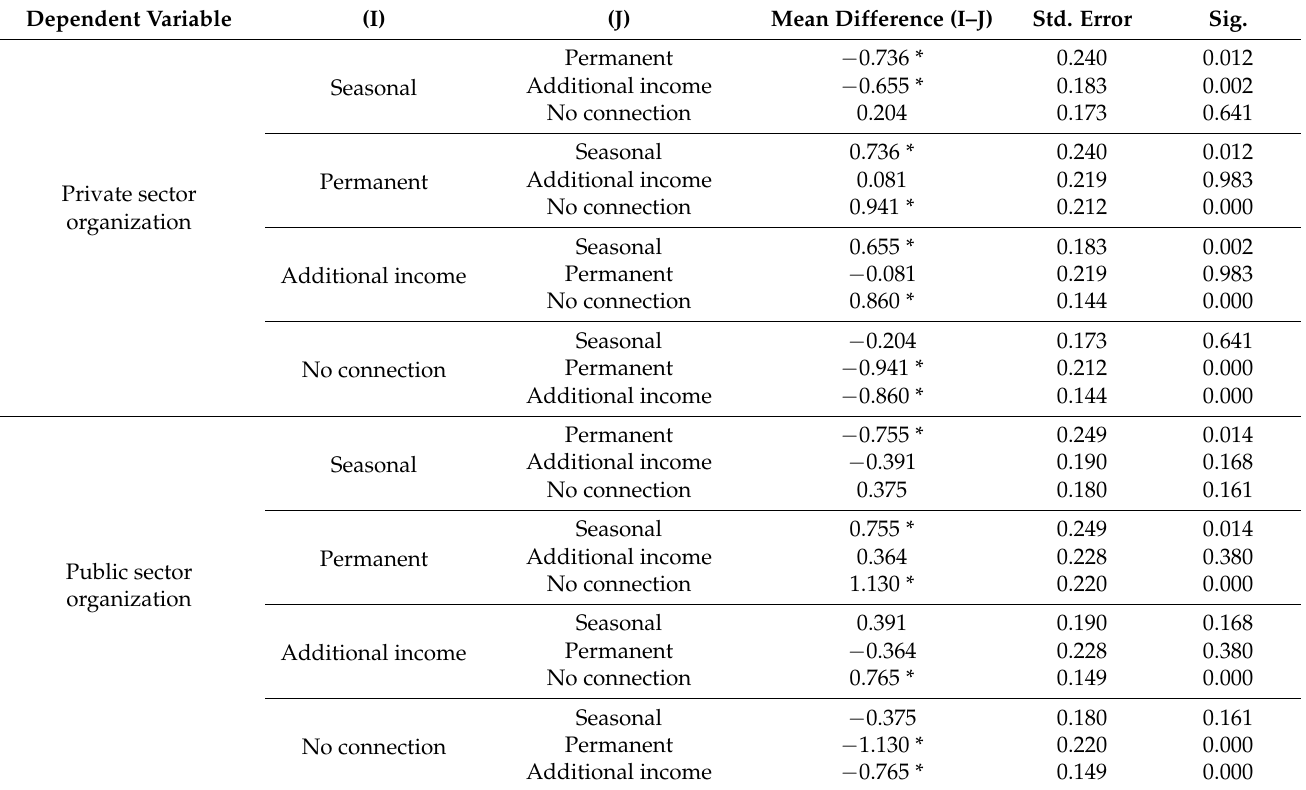
Table 4. Results of post hoc